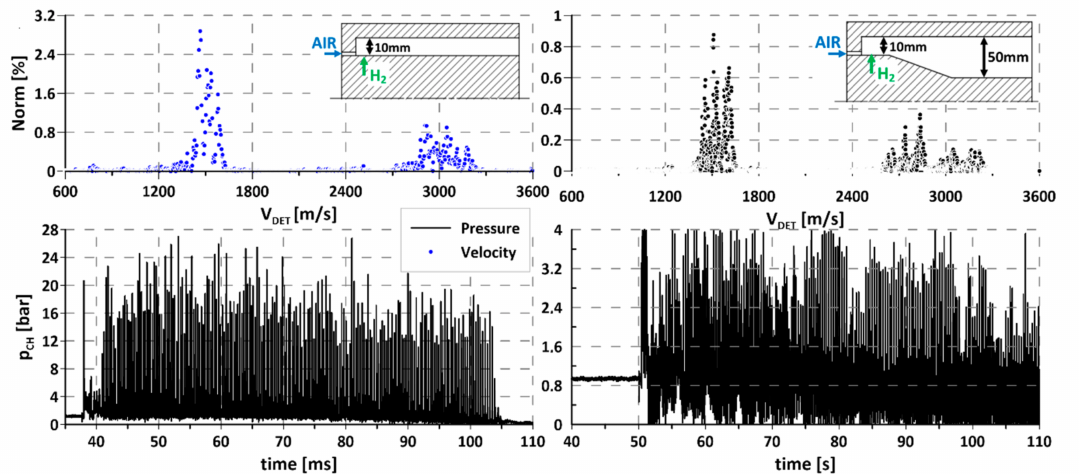
Figure 3. Comparison of propagation of rotating detonation in two di ff erent chamber geometries: ( left ) designed for hydrogen–air mixture; ( right ) designed for kerosene–air mixture. Upper part, propagation